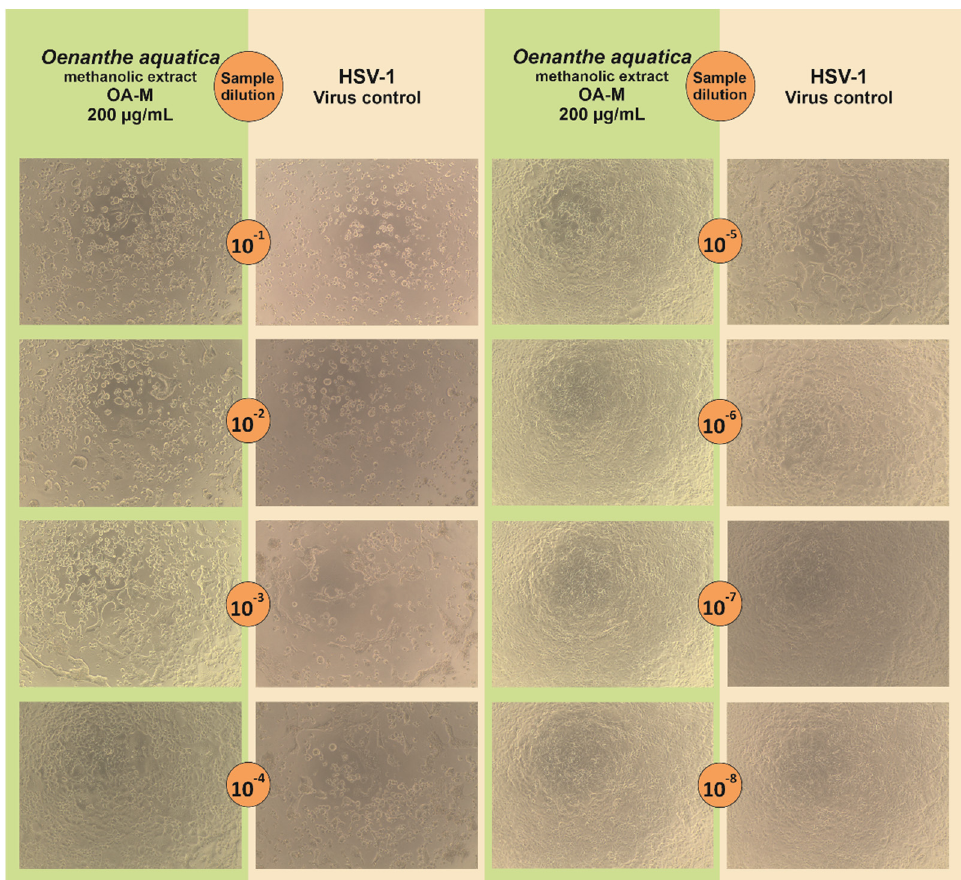
Figure 4. Oenanthe aquatica methanolic extract (200 µg/mL) end-point HSV-1 titration assay (the numbers in circles refer to tenfold dilutions of samples collected from antiviral assays).